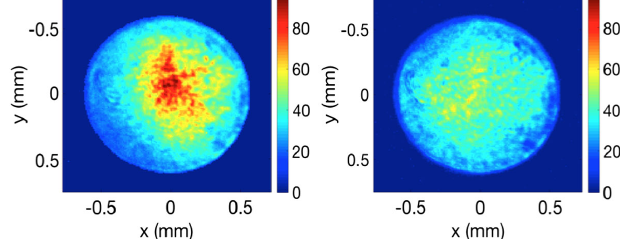
FIG. 7. Drive laser profiles for preliminary emittance measure- ments.